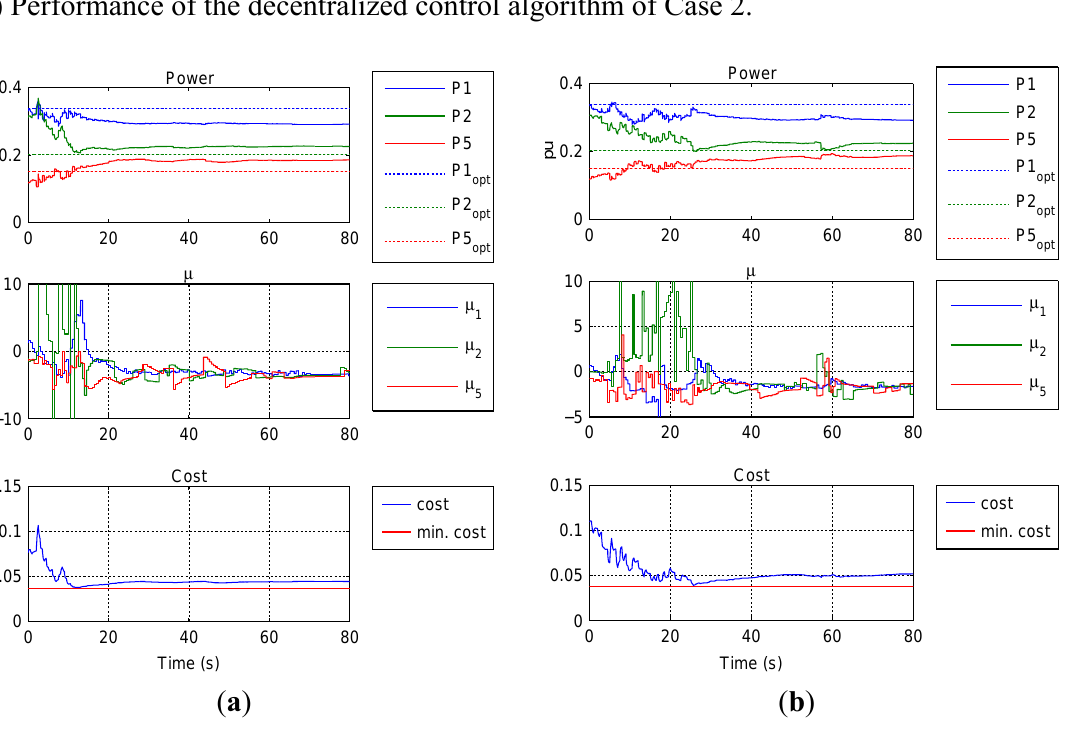
6. ( a ) Performance of the decentralized control algorithm of Case 1; ( b ) Performance of the decentralized control algorithm of Case